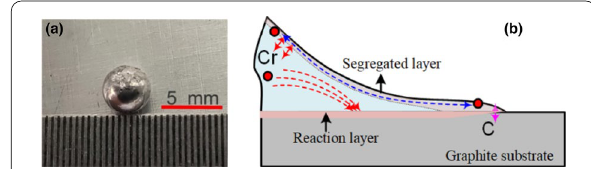
Figure 9 ( a ) Bead of Cu-20Sn-1Cr after arc melting, and ( b ) schematic of possible spreading